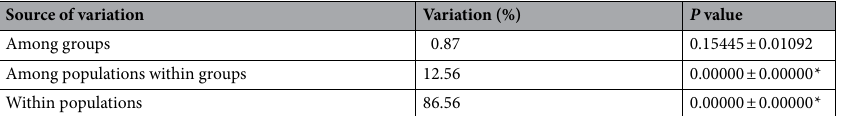
Table 2. AMOVA: Arabs versus Berbers versus Andalusians versus Cosmopolitans. Arabs: Kairouan, Wesletia, Zriba. Berbers: Sejenane, Takrouna, Chenini-Douiret, Jradou, Sened, Bou Omrane, Bou-Saad, Kesra. Andalusians: Zaghouan, Qalaat-El-Andalous, El Alia, Testour, Slouguia. Cosmopolitans: Tunis, Sousse. * P value < 0.05.